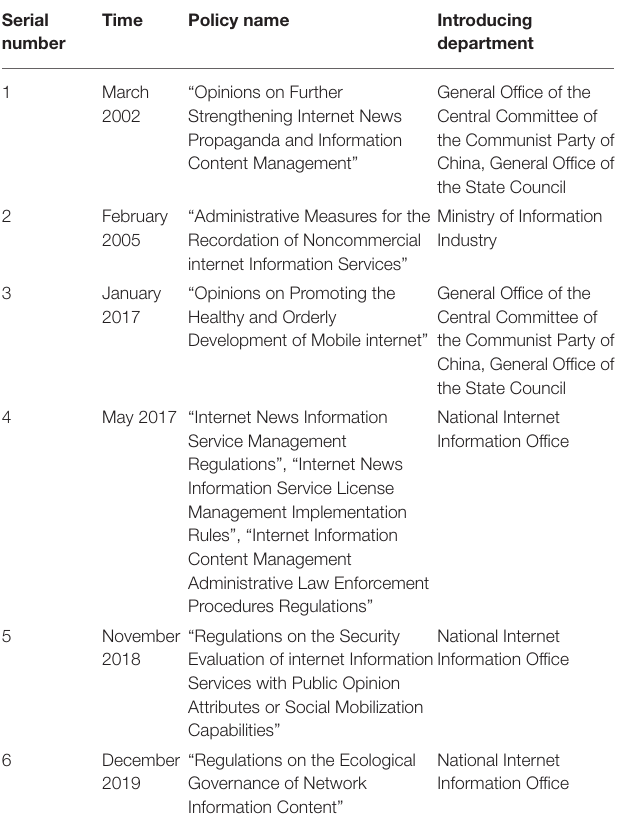
TABLE 1 | Media policies issued by the central